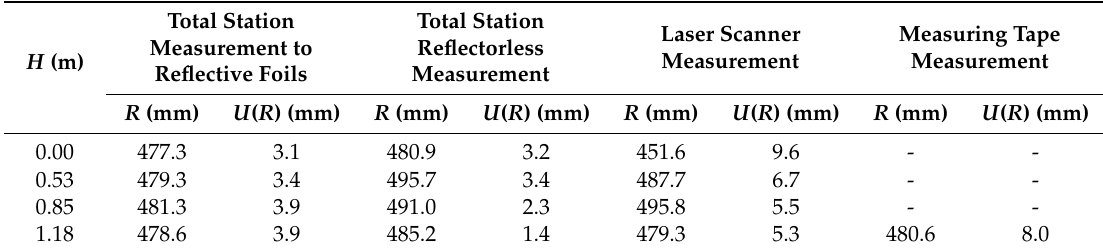
Table 1. Radius of circles R and expanded uncertainty of radius U ( R ) obtained for considered measurement